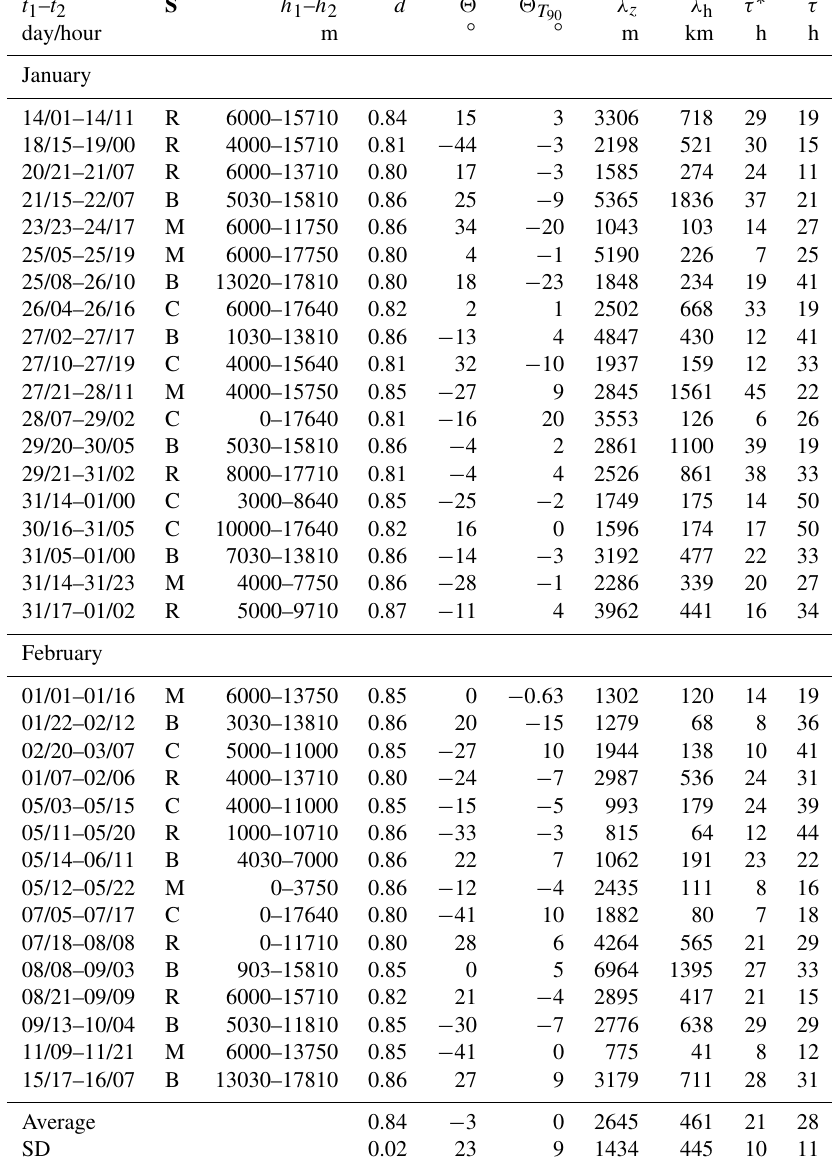
Table 1. For all identified wave events, columns list the (1) time interval t 1 – t 2 as “start date/start hour–end date/end hour” with hour in UTC, (2) data set S (R: RH-Brown ; M: Meteor ; B: BCO; C: combined), (3) altitude interval h 1 – h 2 used for the computation of Stokes parameters, (4) degree of polarization d , (5) wave propagation direction (cid:50) counterclockwise from the eastward direction computed with the Stokes parameters, (6) wave propagation direction (cid:50) T obtained with Eq. (1), (7) vertical wavelength λ z , (8) horizontal wavelength λ h , (9) intrinsic 90 period τ ∗ , and (10) ground-based period τ obtained from the quadrature